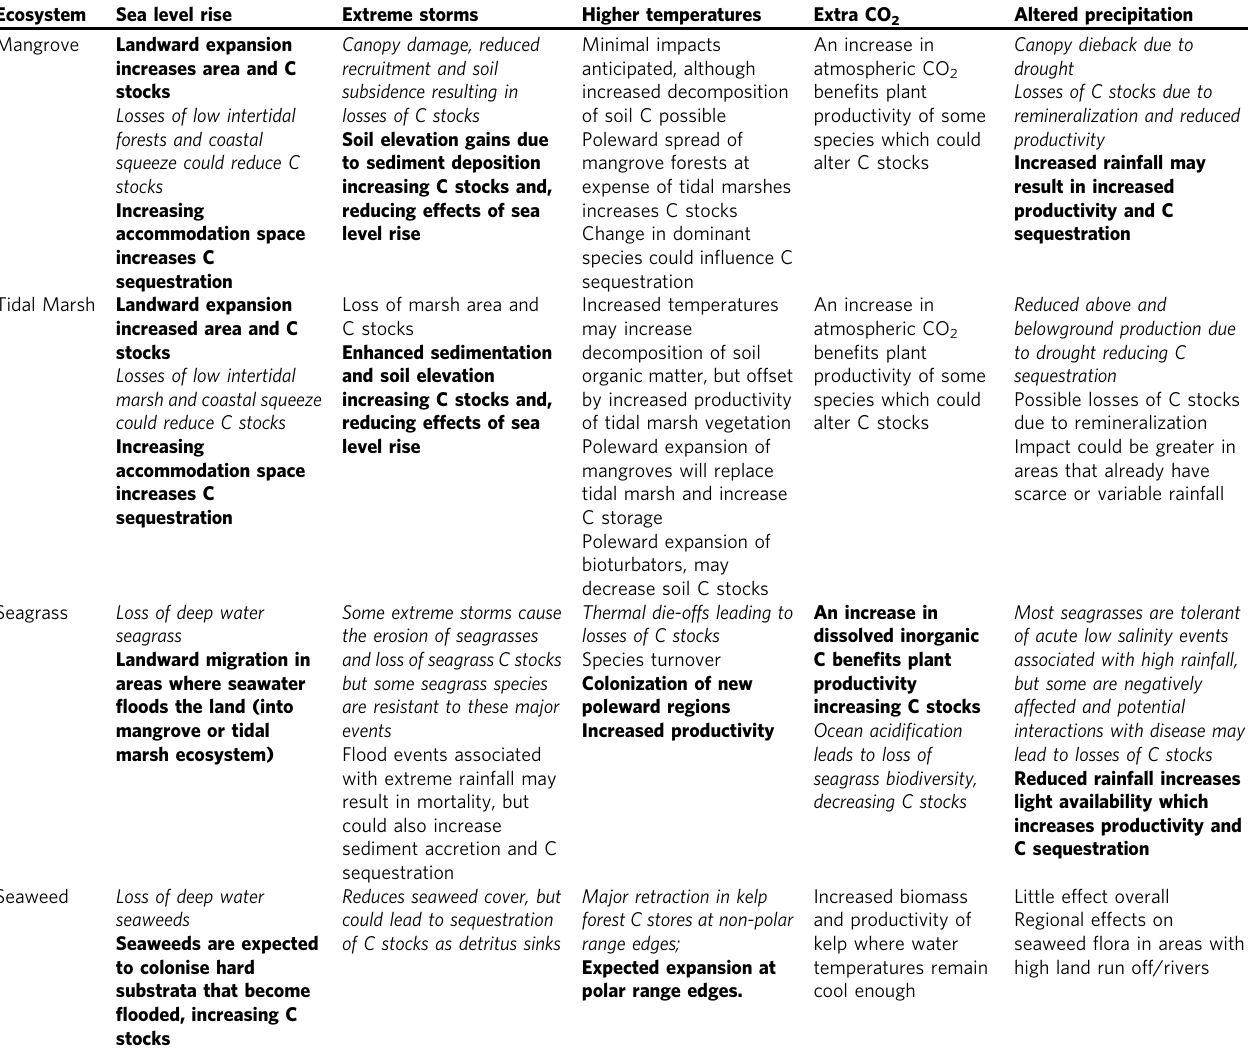
Table 1 Examples of gains and losses for BC stocks with a range of climate change factors